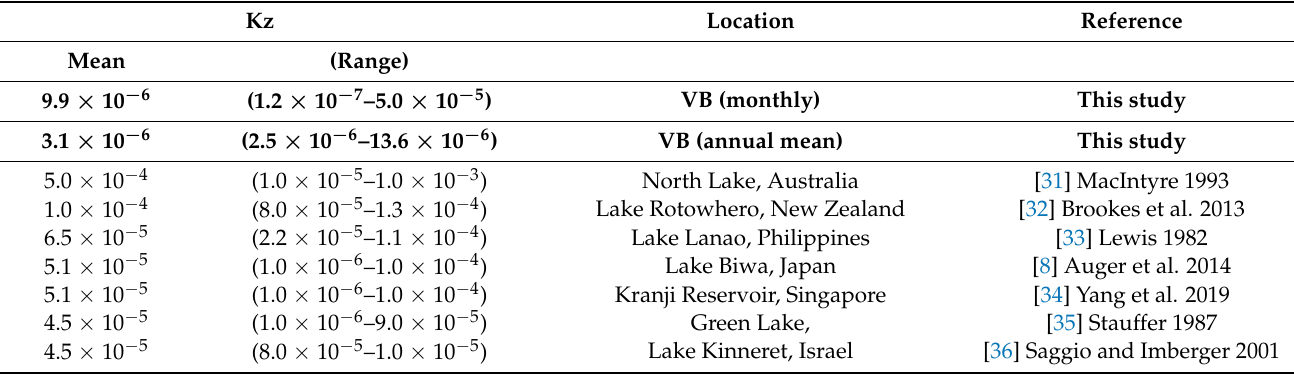
Table 2. Mean and range of the vertical diffusion coefficients Kz (m 2 s − 1 ) obtained for VB during the stratification periods of 2001–2021 and a comparison with Kz reported for other water bodies. The mean and range (in parenthesis) of Kz values are included. Data are ordered from higher to lower Kz mean values, and the position of VB among other lakes and reservoirs is outlined in bold characters and green shading. When not reported, mean Kz were calculated from the values available. The value for molecular conductivity is included to show the lower limit of Kz when mixing is null, and only molecular movements